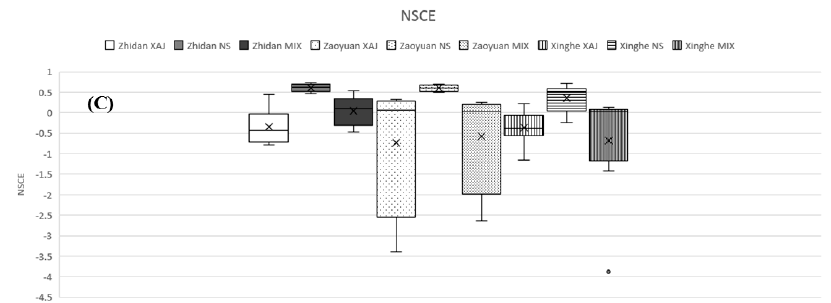
Figure 9. Boxplots of NSCE; ( A ) humid regions; ( B ) semi-humid semi-arid regions; ( C ) arid regions.